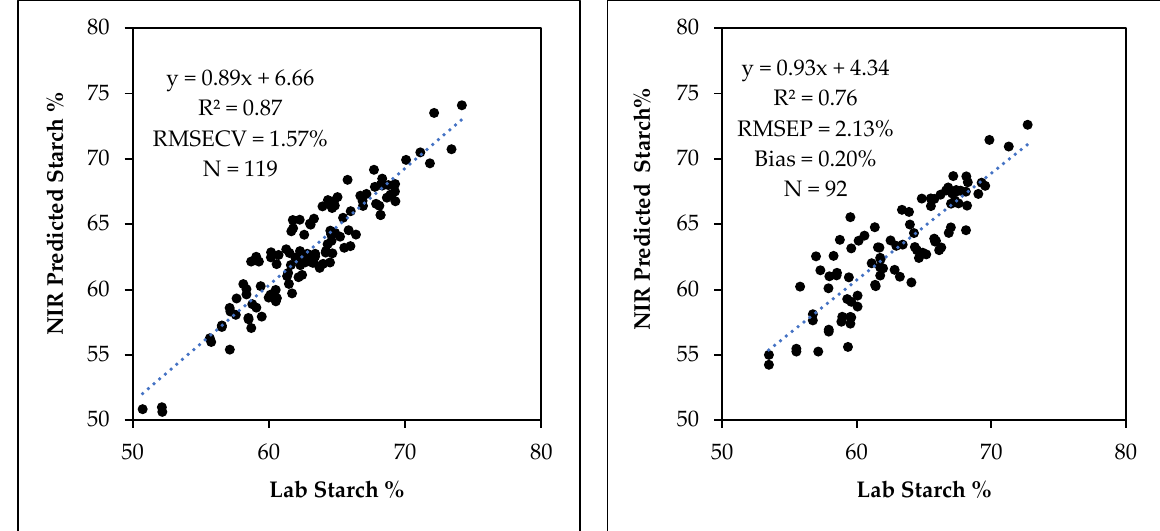
Figure 3. The relationship between laboratory determined and NIR predicted starch content for NIR starch calibration ( left ) and validation ( right ).